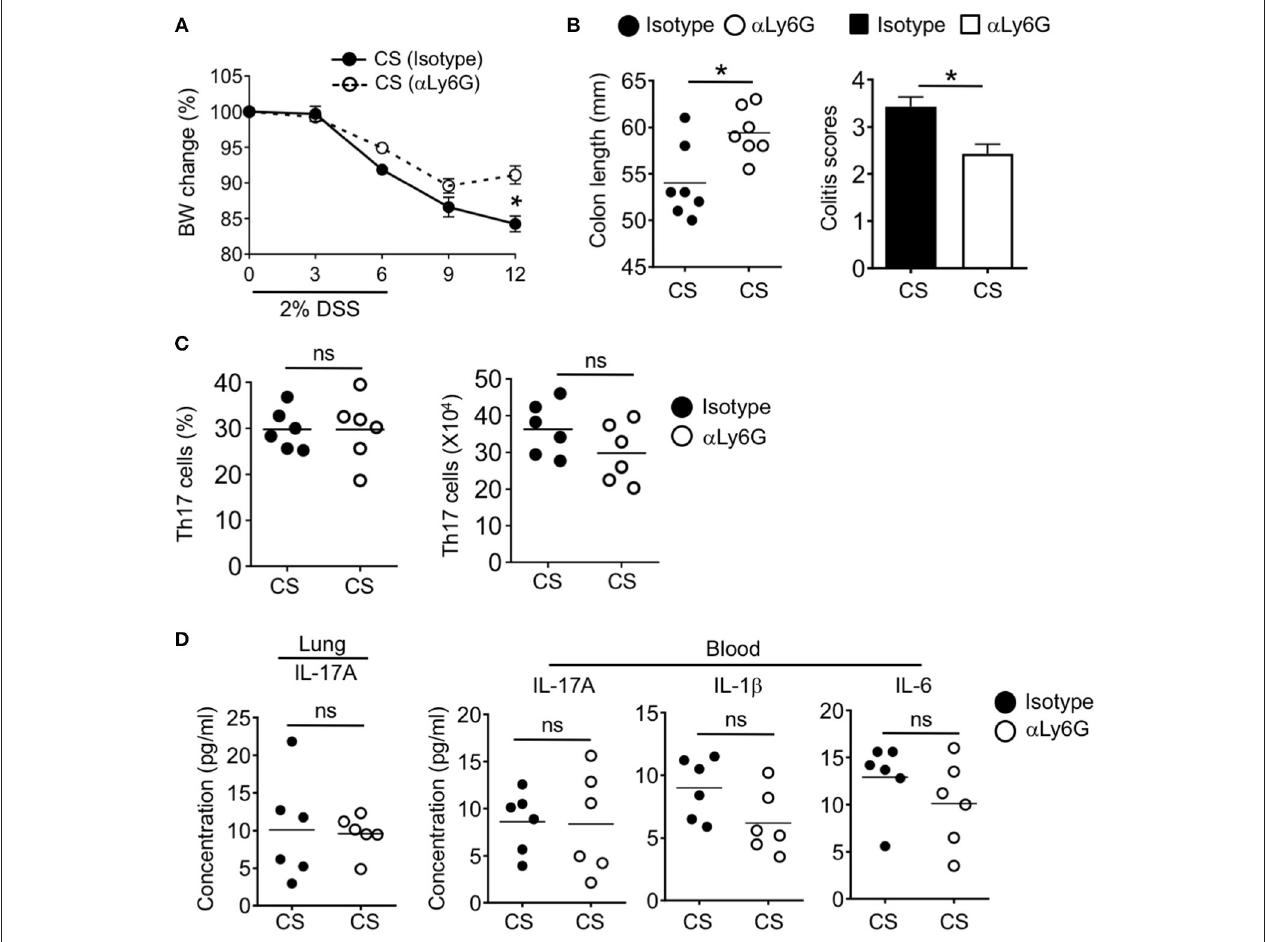
FIGURE 8 | Neutrophils mediate cigarette smoke-enhanced intestinal inflammation. Two months CS exposed mice were treated with 2% DSS followed by treatment with isotype or neutrophil depleting α Ly6G antibody at − 2, 0, and 2 days post-DSS challenge. (A) Body weight change (%) and (B) colon length and colitis scores of CS mice with intact or depleted of neutrophils after DSS-induced acute inflammation. (C) Frequencies and numbers of Th17 cells in the intestine after DSS treatment were assessed by flow cytometry. (D) Quantification of Th17 cell response related cytokines in the lung homogenate and blood by Luminex assay. Data is representative of two independent experiments (mean ± SEM). Representative and pooled data obtained (mean ± SEM) from two independent experiments with 6–7 animals are shown. Mann-Whitney was used to test for significance. ns, P > 0.05; * P ≤